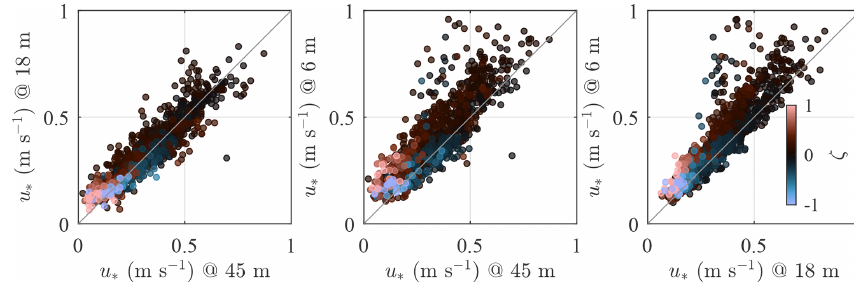
Figure 4. Friction velocity estimated by the three sonic anemometers on SMW for a wide range of stability conditions with | ζ | < 2.